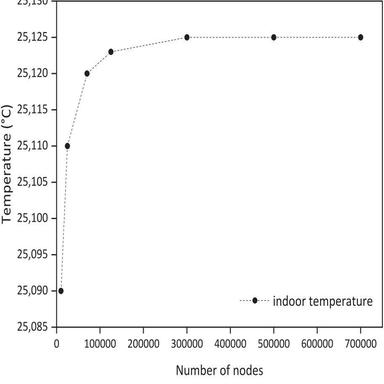
Mesh independence test of the studied wall.